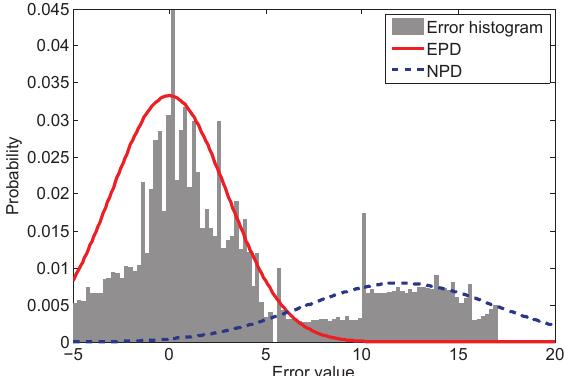
Figure 1. Measurement error histograms and the dynamic Gaussian model for measurement